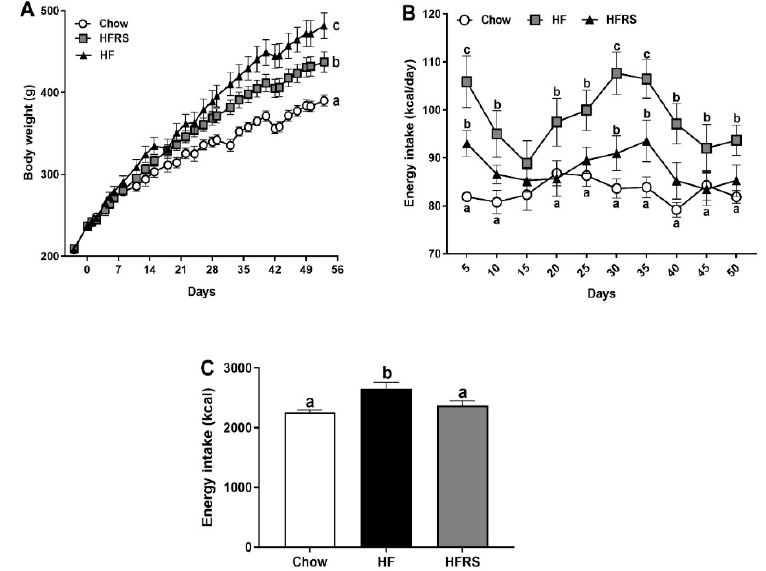
Figure 1. Potato RS reduces weight gain and prevents hyperphagia. ( A ) HF feeding led to a significant increase in body weight compared to control chow-fed conditions. The RS supplementation partially normalized weight gain. ( B ) The HF feeding led to a significant initial increase in energy intake in both HF and HFRS rats. The HF-fed rats’ intake was significantly higher than chow-fed animals throughout the study with the exception of week 2. After initial hyperphagia, HFRS rats’ energy intake normalized to the level of chow-fed rats, with the exception of week 4. ( C ) Overall energy intake was significantly higher in HF rats compared to both HFRS and chow control. Data are presented as the mean ± SEM; a, b, c different letters indicate statically significant ( p < 0.05) differences among groups. HF = high fat, HFRS = high-fat resistant starch, n = 8 per group.